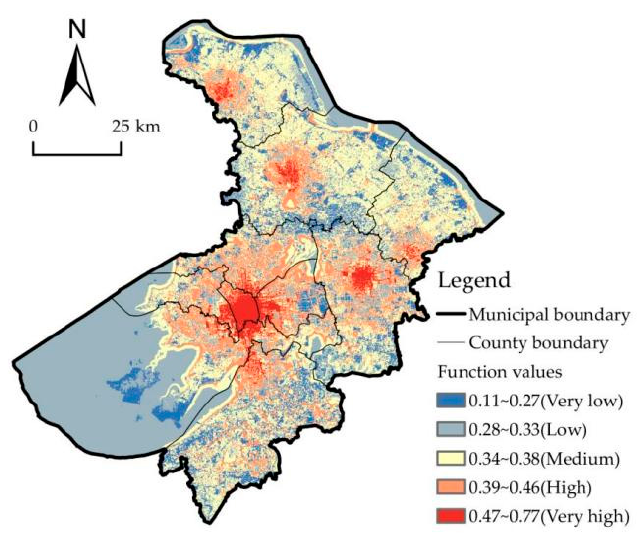
Figure 6. Comprehensive function of production–living–ecological space. Table 7. The directional index of production–living–ecological space functions